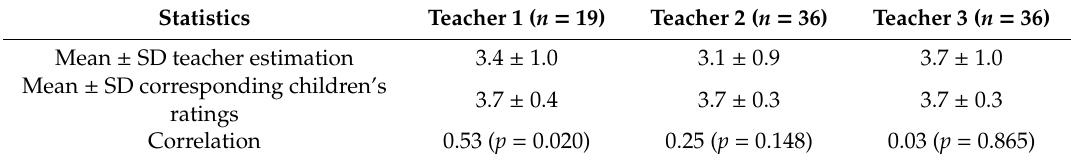
Table 3. Concordance between teachers’ estimation and children’s